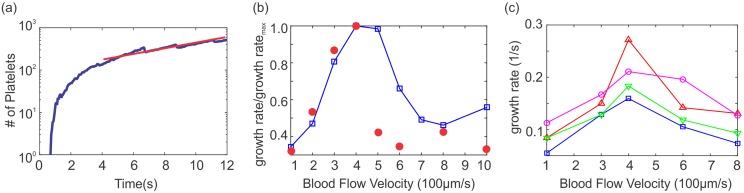
Low-shear simulation results of blood clotting in a 50μm circular tube.(a) A typical example of the number of platelets aggregated in the thrombus vs. time, plotted in semi-log axes. Exponential growth is achieved after a few seconds. The exponential growth rate is computed by fitting the data (red line). (b) Exponential growth rates (normalized by the maximum value) computed from the simulations and plotted as a function of blood flow velocity (−□−). Here, the size of injury is 30μm and platelet concentration is taken as 300,000mm−3; experimental data extracted from Begent and Born [19] (○). (c) Exponential growth rates derived from simulations for three different conditions: platelet concentration taken as 500,000mm−3 (−△−); increased size of injury to 60μm (−▽−); and the inclusion of shear-induced platelet’s drift according to Eq (6) (−○−). Results from (b) replotted here for comparison (−□−).